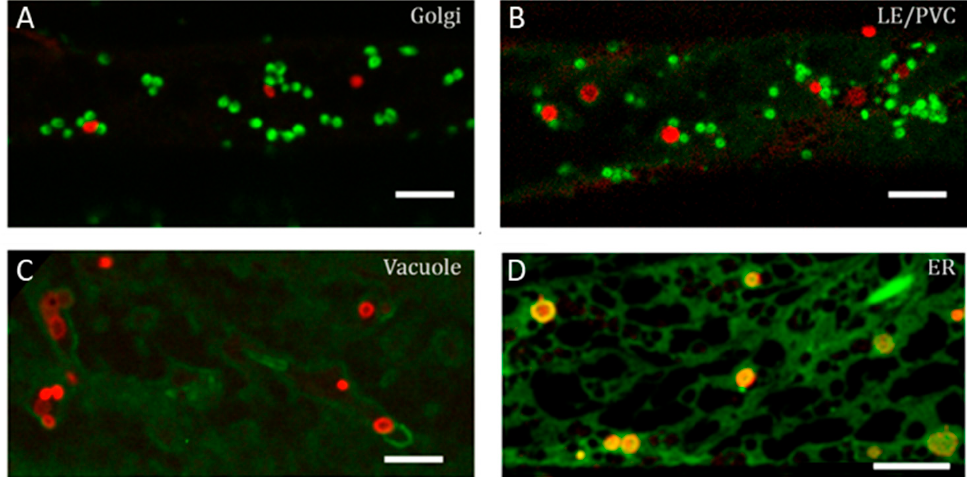
Figure 4. Example of colocalization investigation between the autophagosomes and other endomembrane markers using stable co-expression in Arabidopsis thaliana . F1 plants resulting from the crossing between Arabidopsis lines stably expressing Yellow Fluorescent Protein (YFP) tagged endomembrane markers (green) with a line stably expressing mCherry-ATG8e (red). ( A ) Autophagosome membranes do not show clear colocalization with the Golgi (SYP32); ( B ) nor late endosomes/prevacuolar compartments (LE/PVC, Rab-G3f) or ( C ) vacuoles (VAMP711), with the red signals (autophagosomes) being distinct from the green signals (Golgi, prevacuolar compartments, tonoplast, respectively); ( D ) Interactions with the endoplasmic reticulum (ER) (labeled by a GFP-HDEL fusion) is indicated by the orange color given by the superposition of the green (ER) and red (autophagosomes) signals. Scale bars: 5 µm.